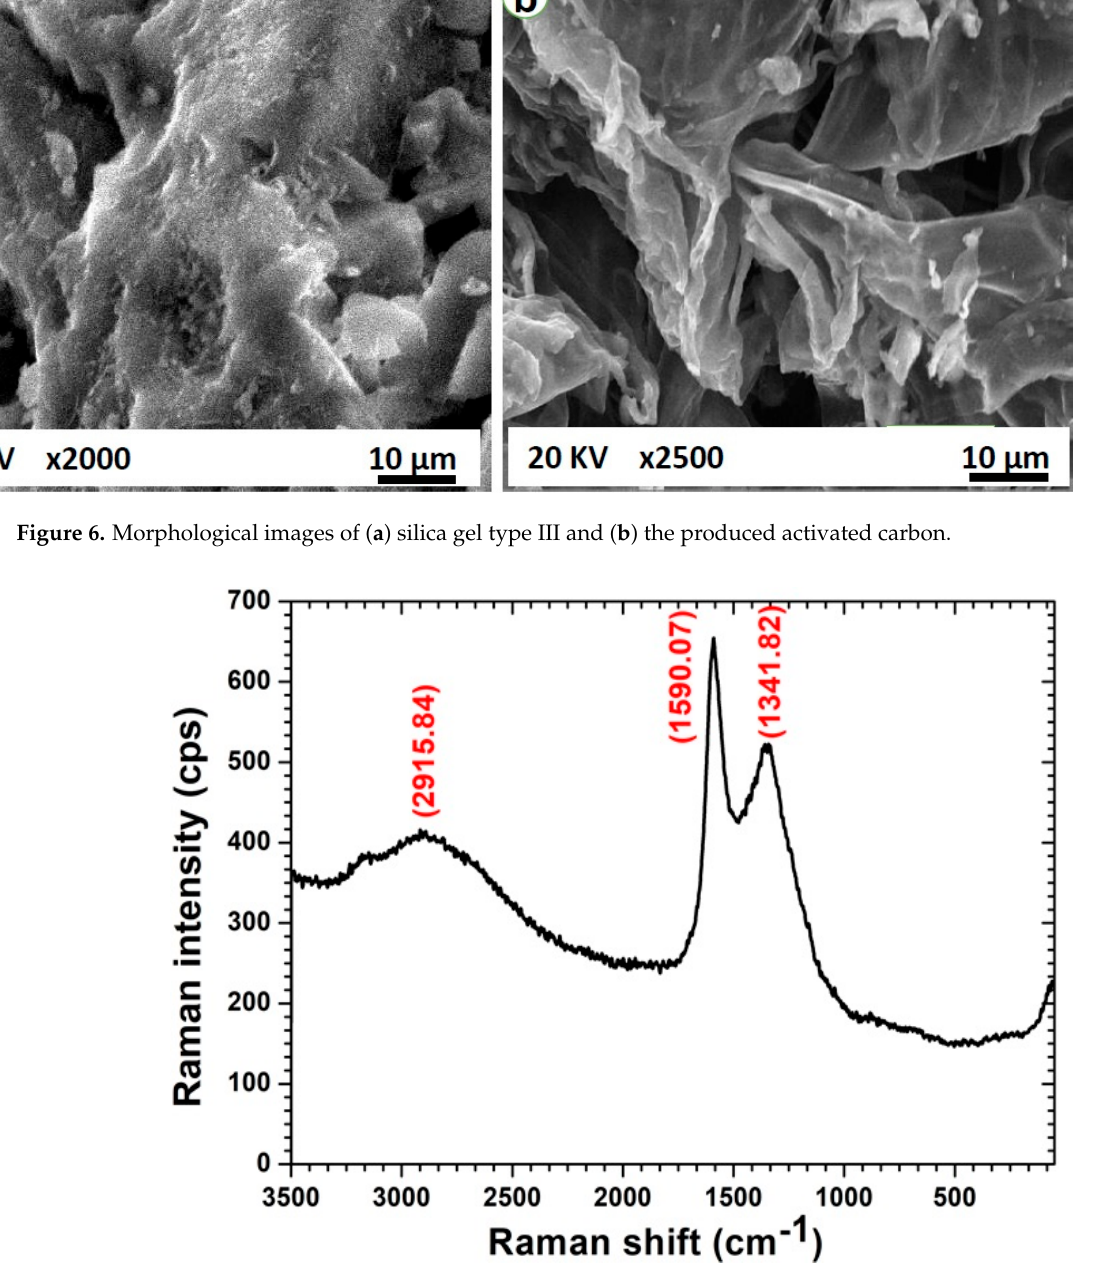
Figure 7. Raman spectra for the produced acrivated carbon in the spectrum range 0–3500 cm − 1 .